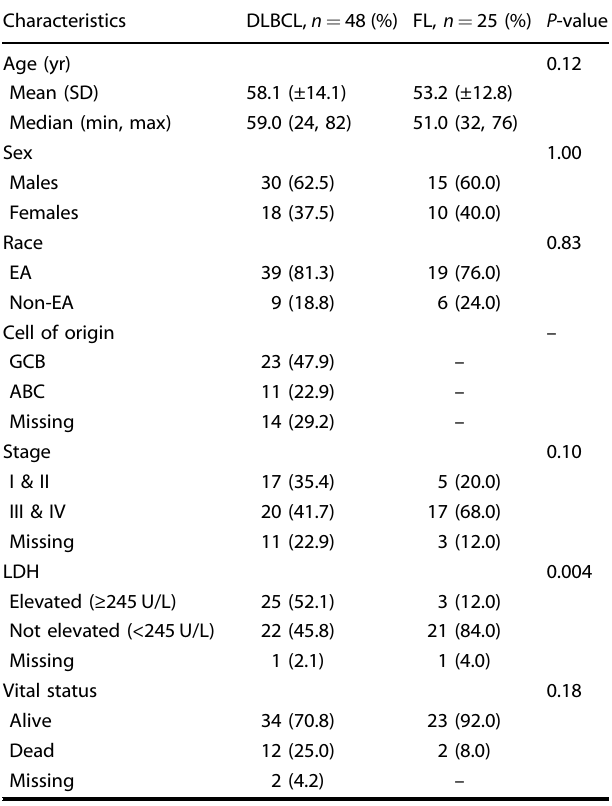
Table 1. Demographics and clinical characteristics of the study subjects.